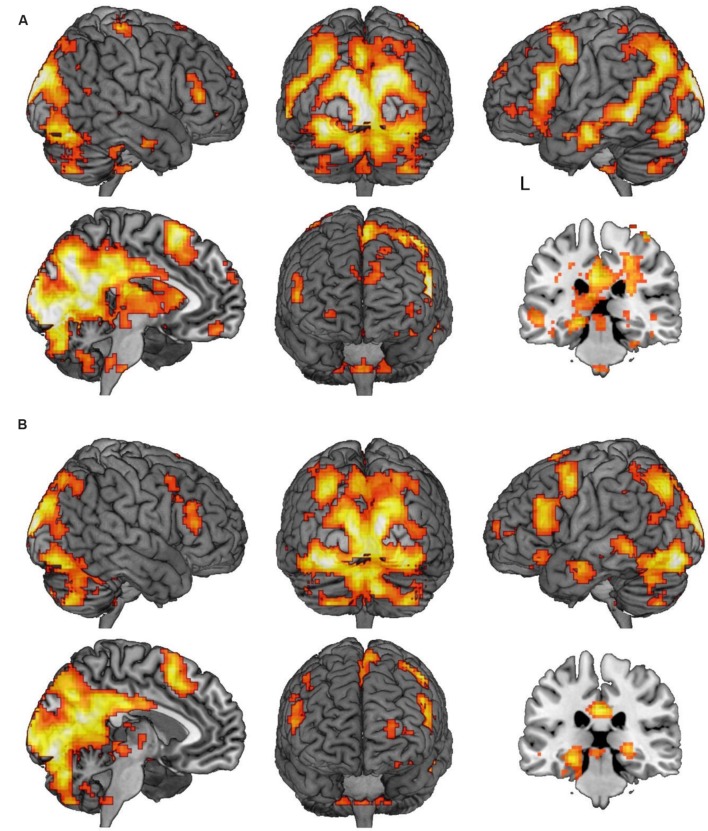
Regions of activation in the think/memory substitution vs. no-think1 and 2 contrasts. (A) Regions demonstrating significant activation in the think vs. no-think1 contrast. (B) Regions demonstrating significant activation in the memory substitution vs. no-think2 contrast. Images in both panels are thresholded at p < 0.001 with clusters comprising a minimum of five contiguous voxels. In both panels, the sagittal slice is marked with an L indicating the side of the left hemisphere and is rendered where x = -5. The coronal slice is rendered at y = -28.